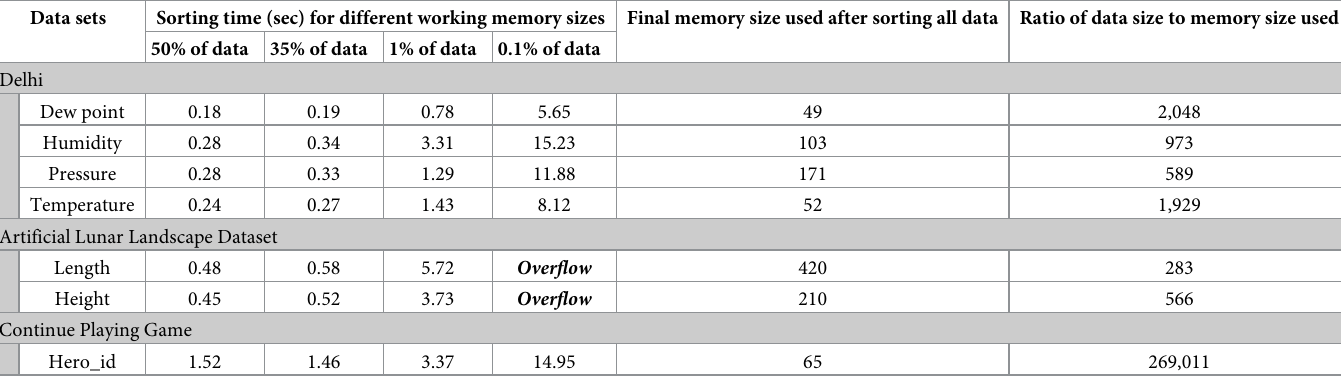
Table 7. The time consumption, memory size for storing sorted data, and the ratio of data size to memory size for storing sorted data for three real-world data sets. Data sets